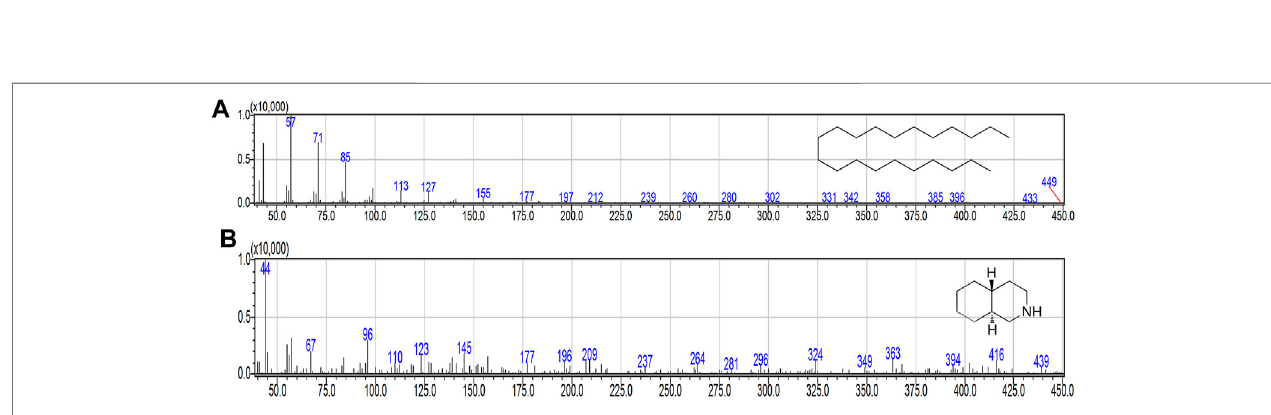
Frontiers in Pharmacology |